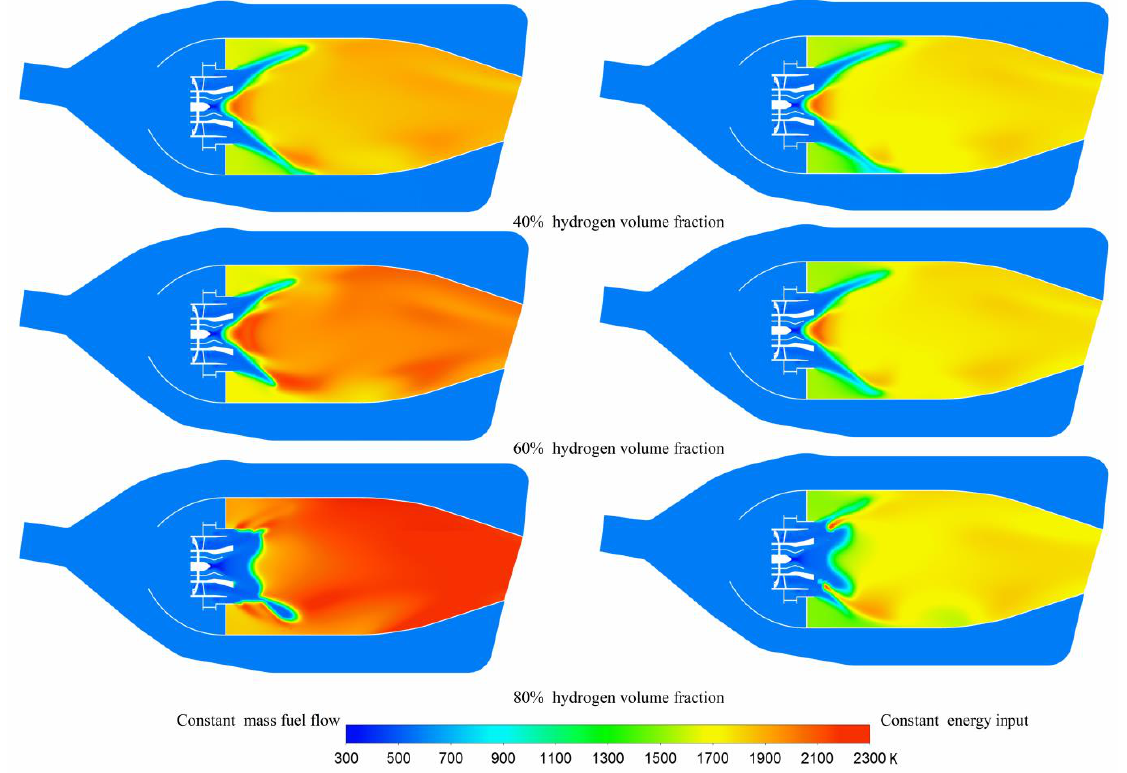
Figure 7. Temperature distribution under different hydrogen volume